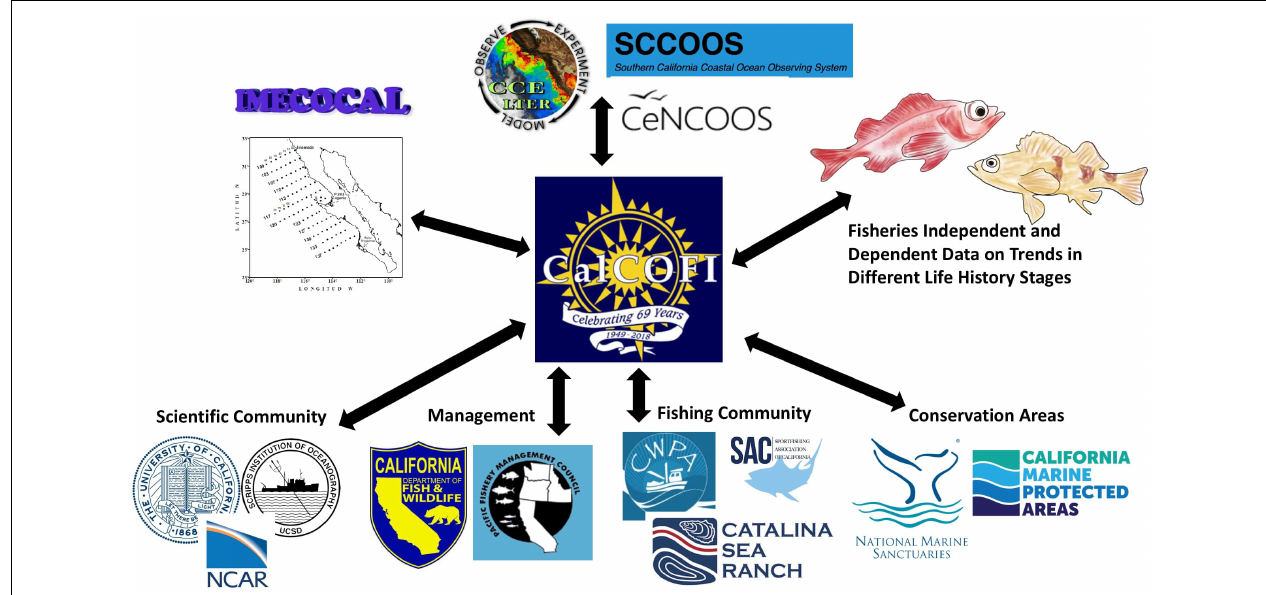
FIGURE 5 | Linking basic monitoring to decision-making for climate change adaptation requires integrating different data streams with the needs of stakeholders. CalCOFI exists alongside a wealth of additional sampling programs that, in concert, allow for comparing changes seen in the CalCOFI record across regions (upper, left), monitoring frameworks within a region (upper, middle), and sampling programs on different fish life stages (upper, right). Trends observed from these monitoring programs can support different stakeholder groups (bottom) including the scientific, management, fishing, and conservation communities on climate change adaptation strategies and actions. Arrows show that information can flow both